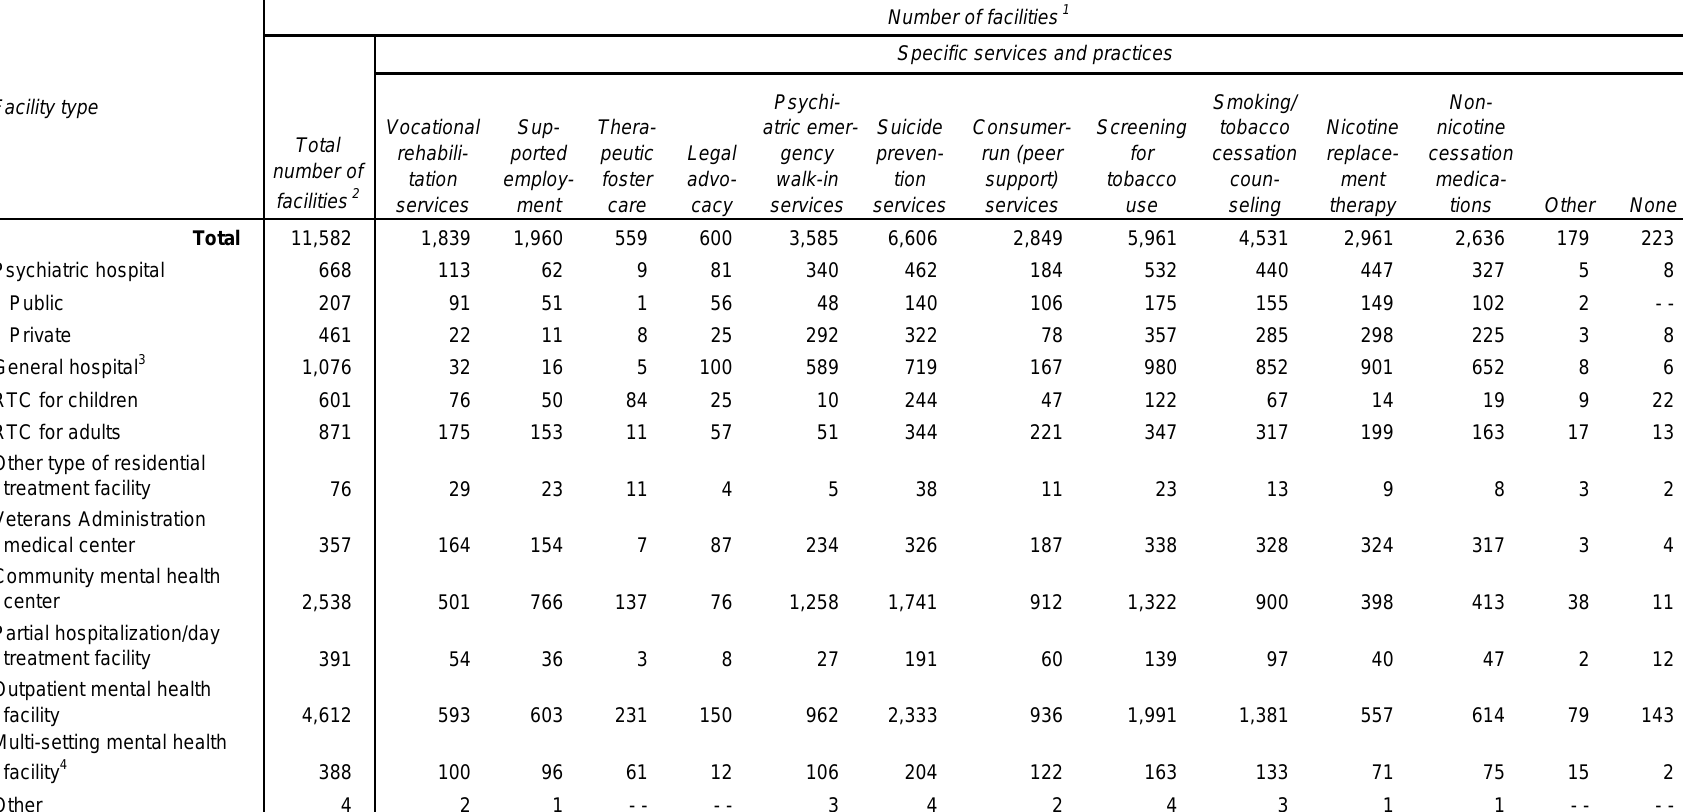
Table 2.4a. Mental health treatment facilities offering specific services and practices, by facility type: Number, 2017